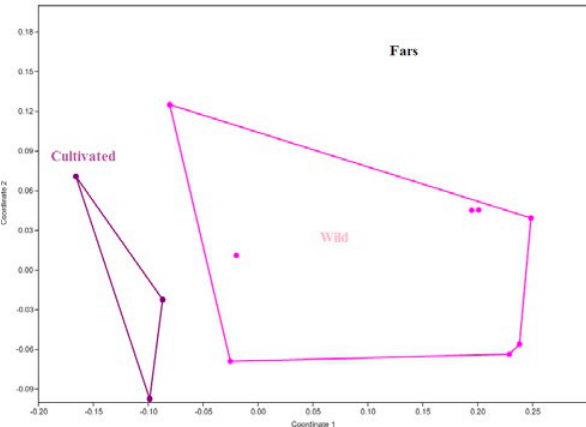
Figure 4. PCoA plot of wild versus cultivated Z. Jujube plants with- in Fars province.